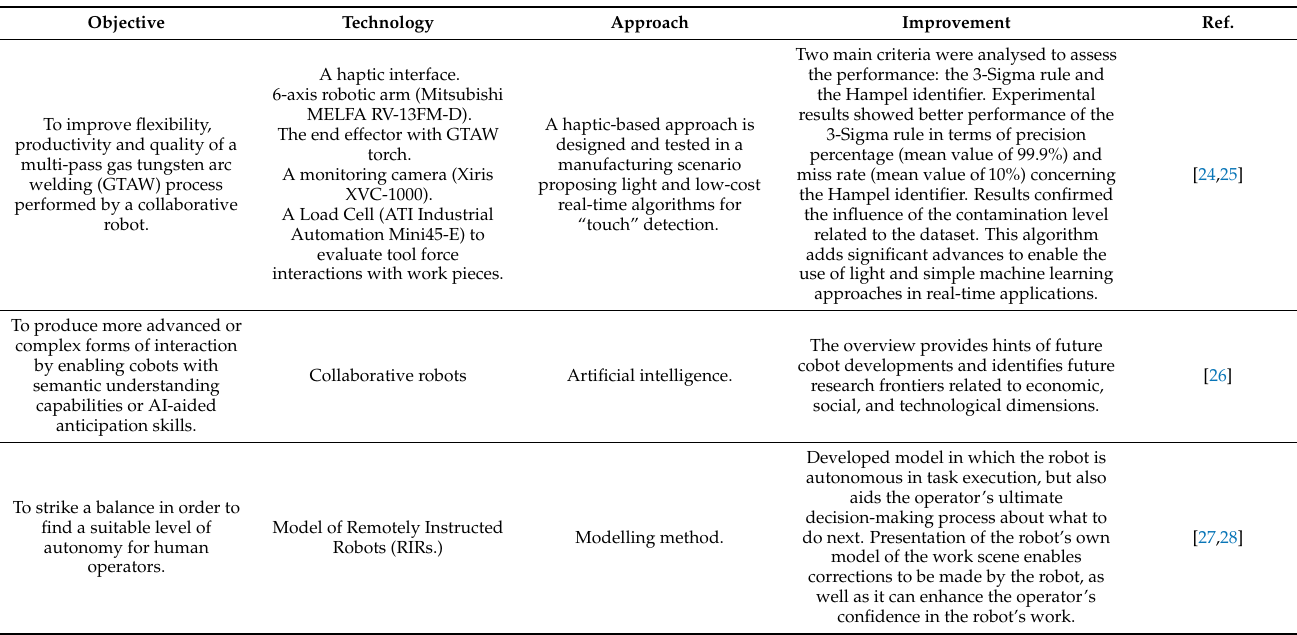
Table 1. Research focused on human–machine